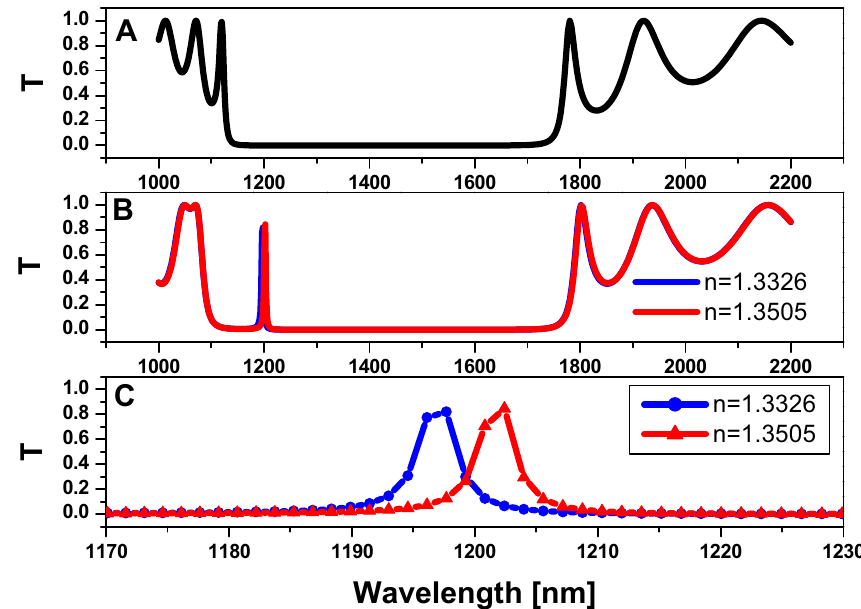
Figure 9. Transmission property of two-dimensional hexagonal cylinder unit cell with R = 250nm D = 120nm , N = 5, and the host material is titanium dioxide ( TiO 2 ) . ( A ) All cylinders are filled with air; ( B ) All cylinders are filled with air except for the centred pour, which is filled with saline water with varying refractive index values; and ( C ) zoom in on the defect peak in figure ( B ).